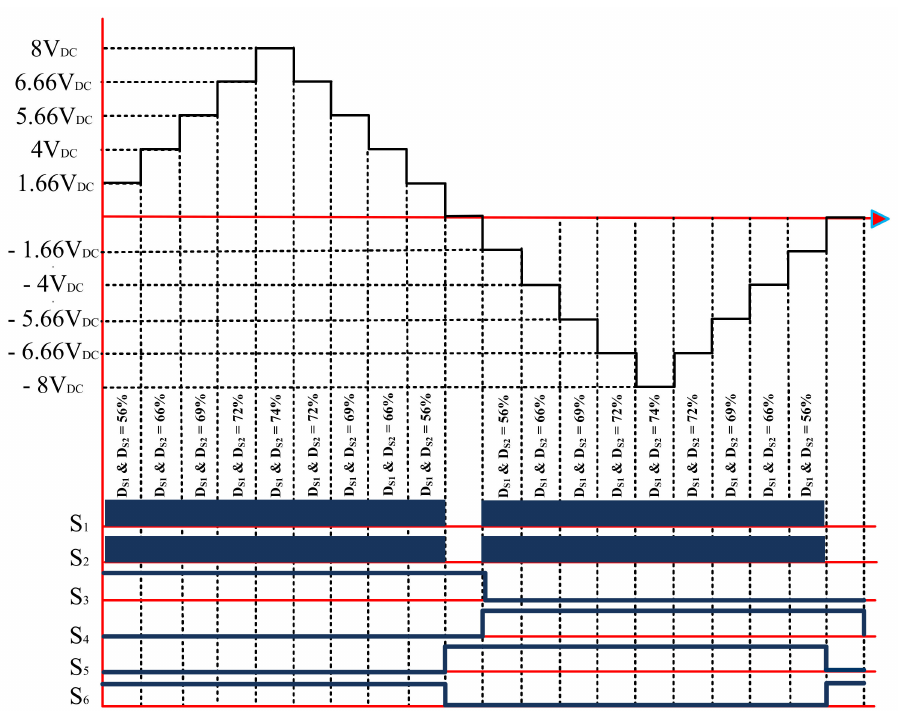
Figure 2. Switching pattern and duty cycle of switches in one-cycle for the proposed multilevel inverter (ex: the number of levels = 11 and gain = 8).